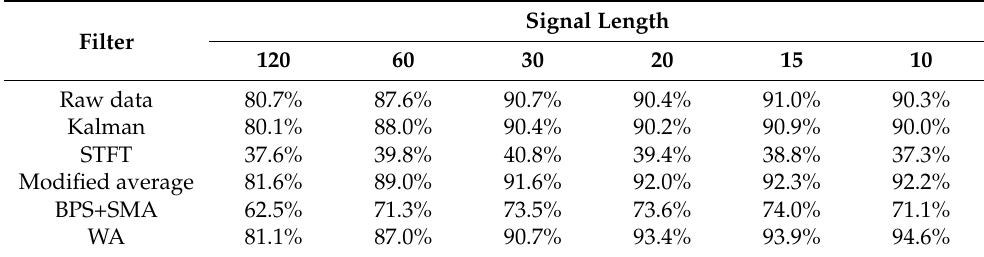
Figure 9. PPG signals for a distance 0.4 mm: ( a ) Raw data; ( b ) Kalman filter; ( c ) STFT; ( d ) Modified average filter; ( e ) BPS+SMA filter; ( f ) WA filter. Table 1. Accuracy of Intellino for filtered PPG data.